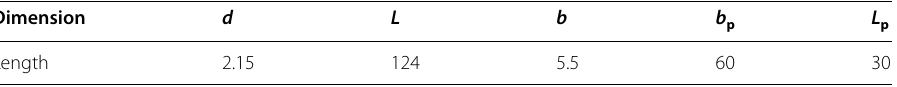
Table 6 Measured